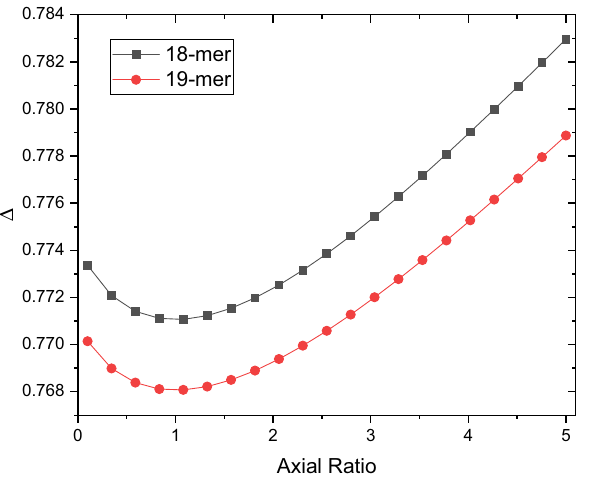
Figure 7. Minimisation function performed by SingleHYDFIT on teicoplanin, using the above hydrodynamic parameters and molar mass consistent with either 18-mer (black square) or 19-mer (red circle). Both plots minimise to an axial ratio of